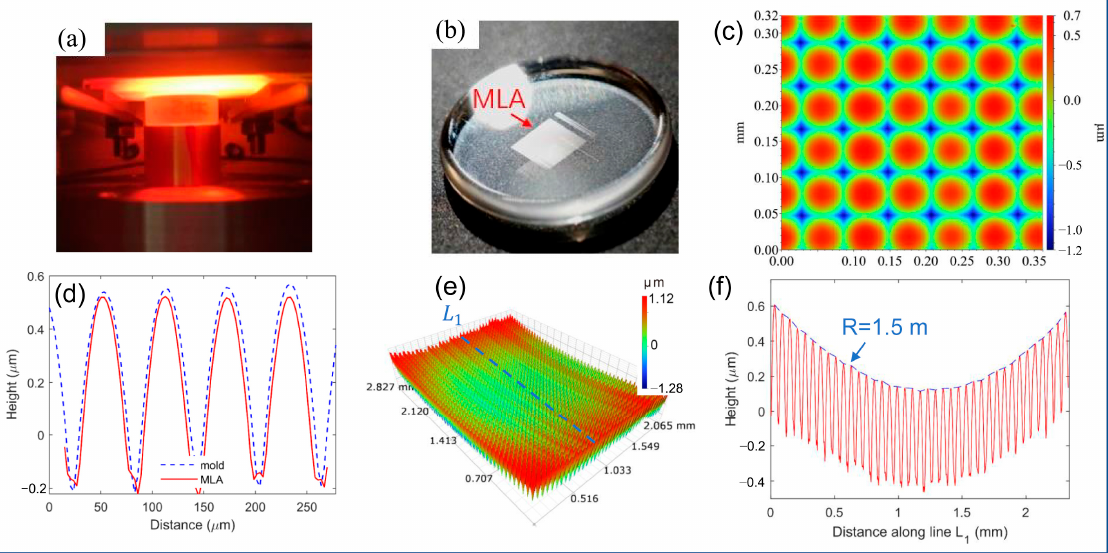
Figure 9. ( a ) Photo of the CBG-heating-based hot embossing in process, ( b ) the embossed MLA on N-BK7 glass wafer, ( c ) contour of a small region in the center of the embossed MLA, ( d ) profile comparisons of the selected MLA in ( c ) with designed mold profile, ( e ) contour of a large region on the MLA, ( f ) the profile scan of the contour in ( e ) along line L 1 .